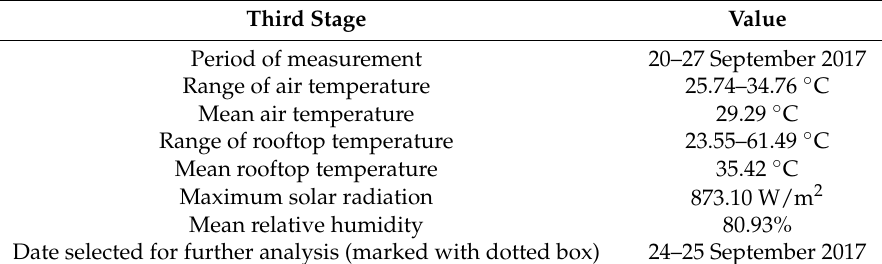
Figure 12. Experimental setup for the third stage. Table 8. Weather data for the third stage (2017/09/20 06:08:41 to 2017/09/27 05:58:41).